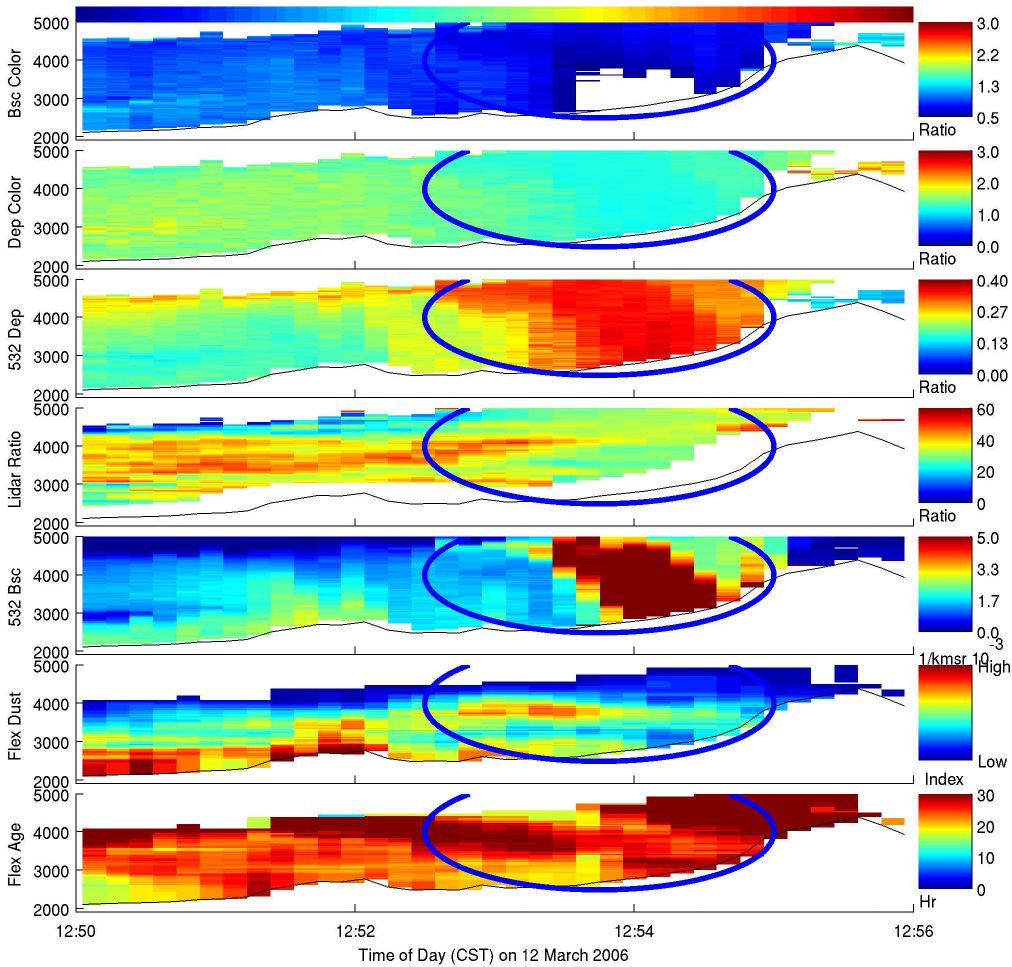
Fig. 6. Curtain plots of HSRL backscatter coefficients and intensive properties on 12 March 12:50 to 12:56 along with Flexpart mean age and particle count index for dust tracers. The blue ellipse shows a dust storm on the mountain slopes. The y-axis is height above mean sea level. The colorbar across the top corresponds to the trajectory shown in Fig.